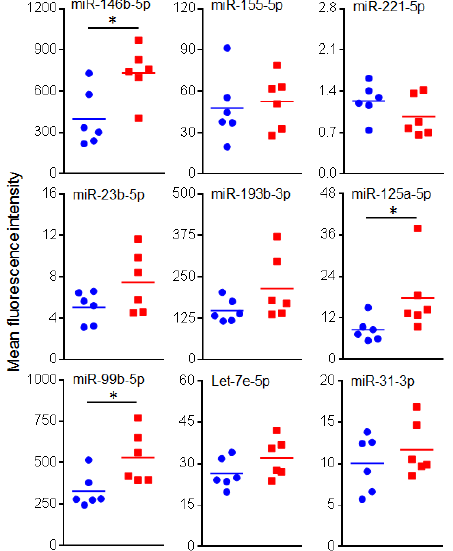
Figure 3. Testing miRNA levels in sera of mice. The levels of miRNAs was determined in serum samples obtained from normal (naïve) control and EAE mice ( n = 6 each) using Multiplex miRNA assay. The data was analyzed using FirePlex Analysis Workbench software, normalized using appropriate controls and presented as mean fluorescence intensity. Blue circle: normal mice, and red square: EAE mice. (* p < 0.05).